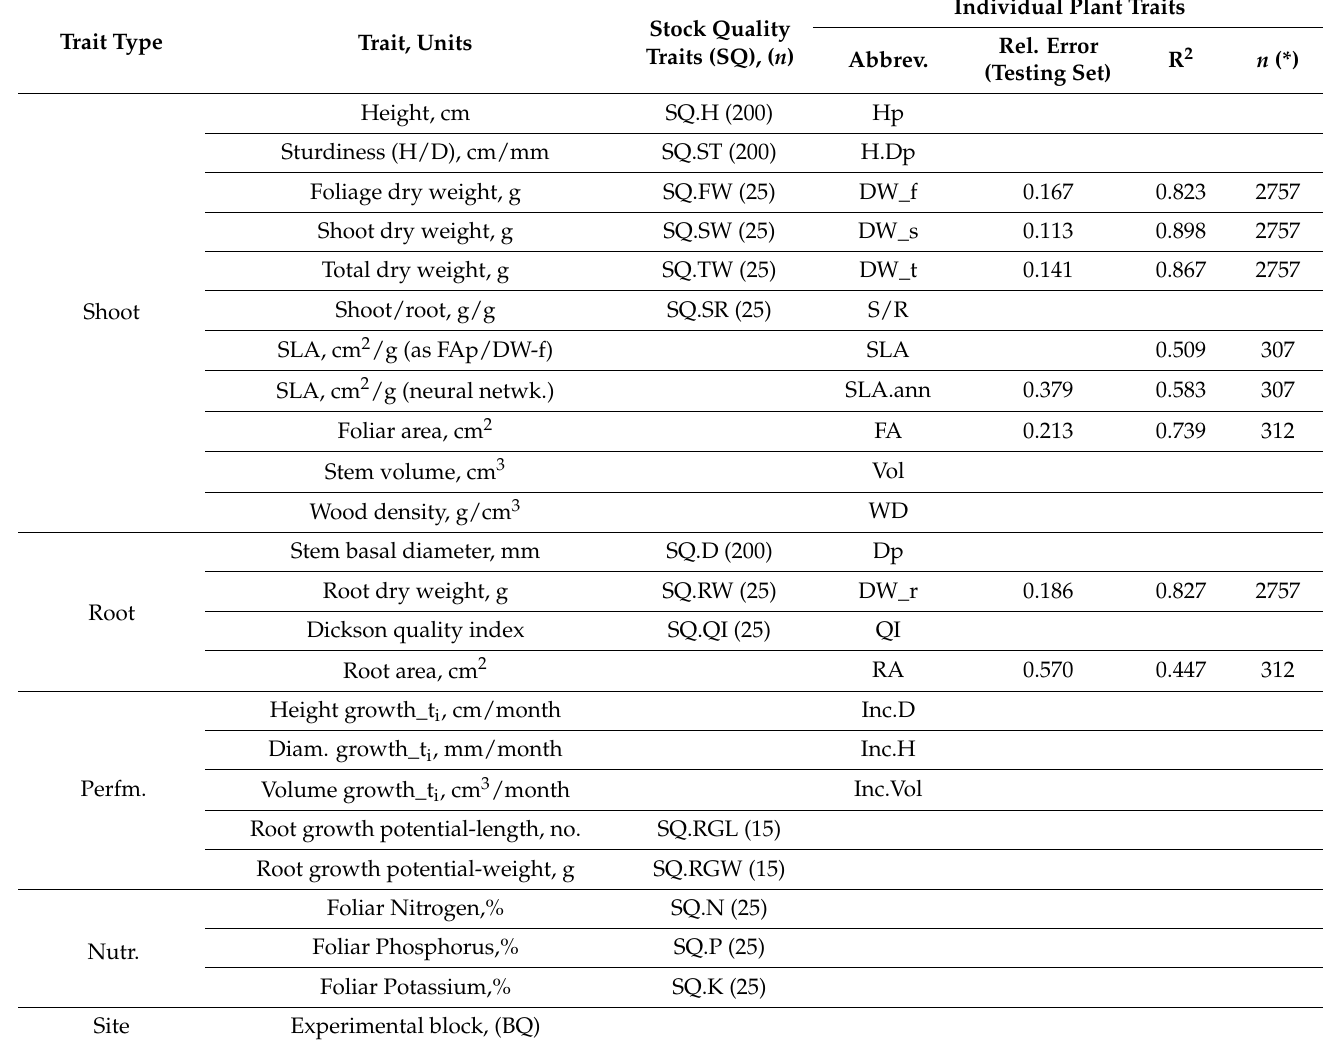
Table 2. Stock quality attributes and plant traits used in this work and the abbreviations used in both the stock quality assessment and the individual plant assessment. In the latter case, the relative error, R 2 , and sample size are presented for the estimated traits with artificial neural networks (SLA was also estimated as the ratio